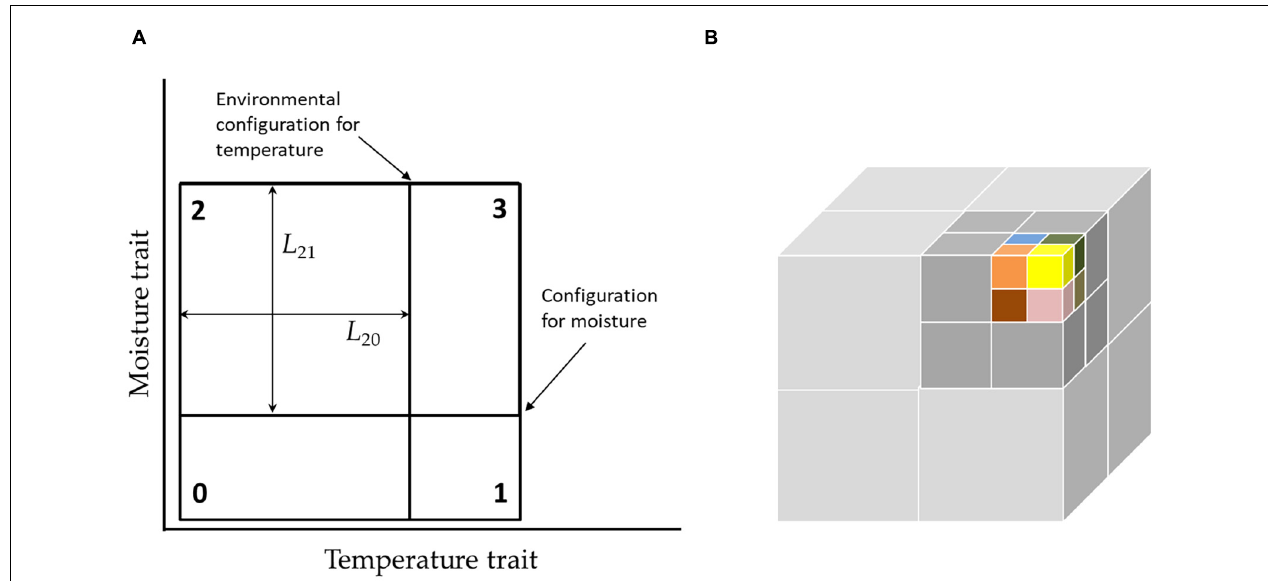
FIGURE 1 | (A) Environmental configurations and niche widths in a two-axis hypercube. In this picture, the current configuration (position of partitions) favors species-2, which likes a cool but moist environment, since this has the largest area. In our graphic notation, note that the position of the environmental configuration, does not mean exactly temperature relative to the axis, but means that degree to which the environment favors hot or cold adapted species. (B) While the full niche hypercube cannot be depicted for more than 3 dimensions, the structure of the community can be depicted by “unfolding” the higher-dimensional hypercube into lower dimensions. Here, a six-dimensional community with 64 species is represented by 8 by 2 × 2 × 2 sub-cubes stacked to form a single “super-cube” of size 4 × 4 × 4. In turn this may be nested within another cube of size 8 × 8 × 8, and so on. This requires, that changes in the faster processes are mirrored in all